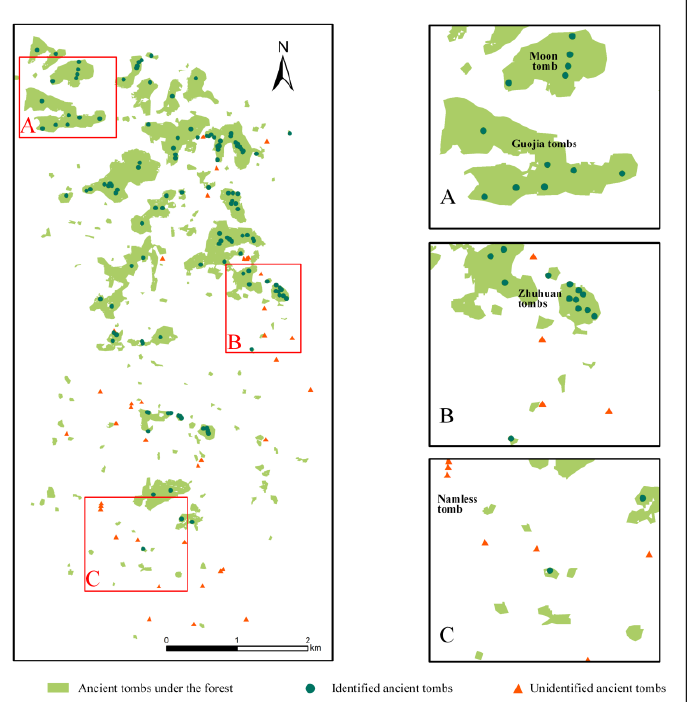
We overlay the processed results with the known tomb sites, as shown in Figure 15.